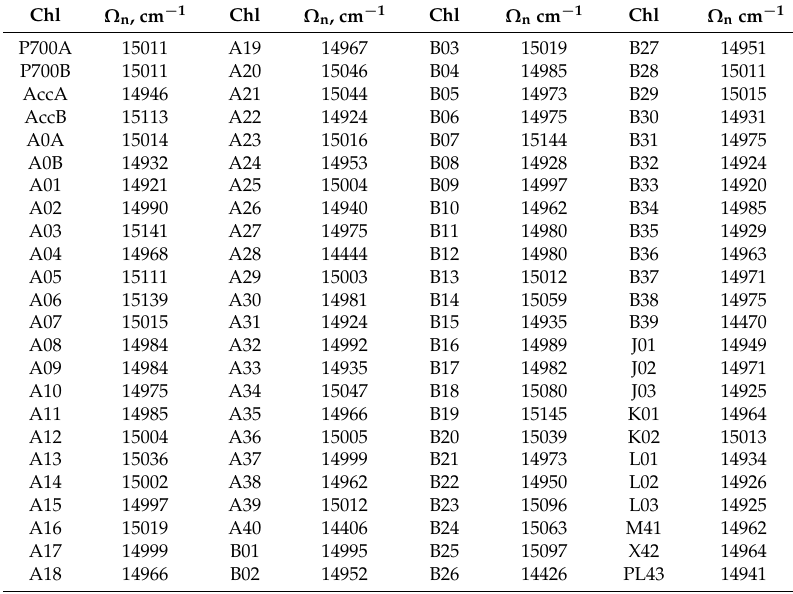
Table A2. The Ω n site energies for the PSI monomer model used to simulate the linear and fluorescence spectra at cryogenic temperature. In the case of PSI trimer calculations, the site energies for two Chls of the PsaL subunit are changed to Ω L01 = 14264 cm − 1 and Ω L02 = 14456 cm − 1